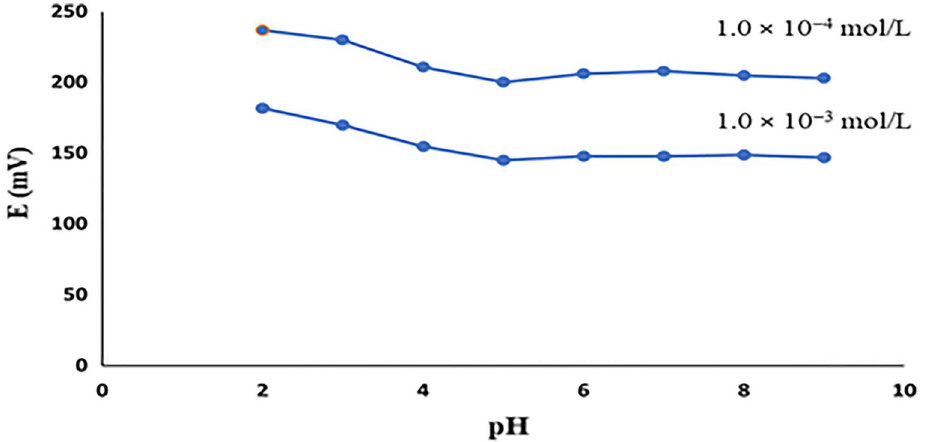
Figure 5. pH effect on response of the PEDT-modified